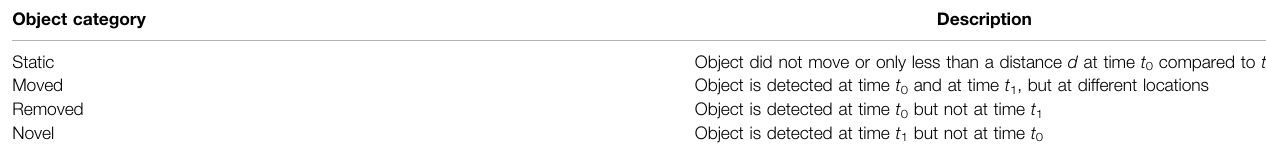
TABLE 1 | De fi nition of the different categories an object gets assigned to when comparing an environment at two different timestamps. Object category